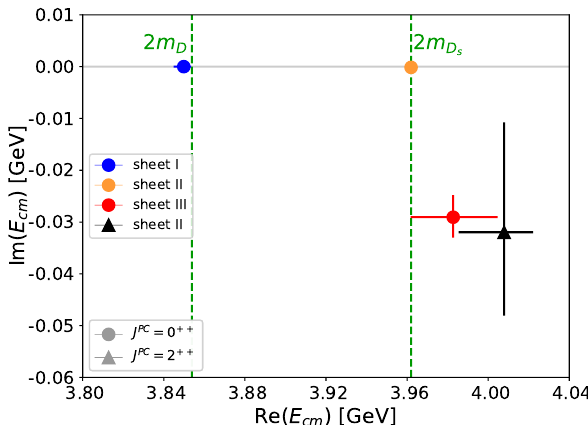
Figure 9 . Pole singularities of the scattering amplitude/matrix in the complex energy plane, which are associated with the hadrons predicted in this work. The pole related to the J PC = 2 ++ resonance appears on sheet II, as we have neglected the l = 2 partial wave contribution from D s ¯ D s scattering.